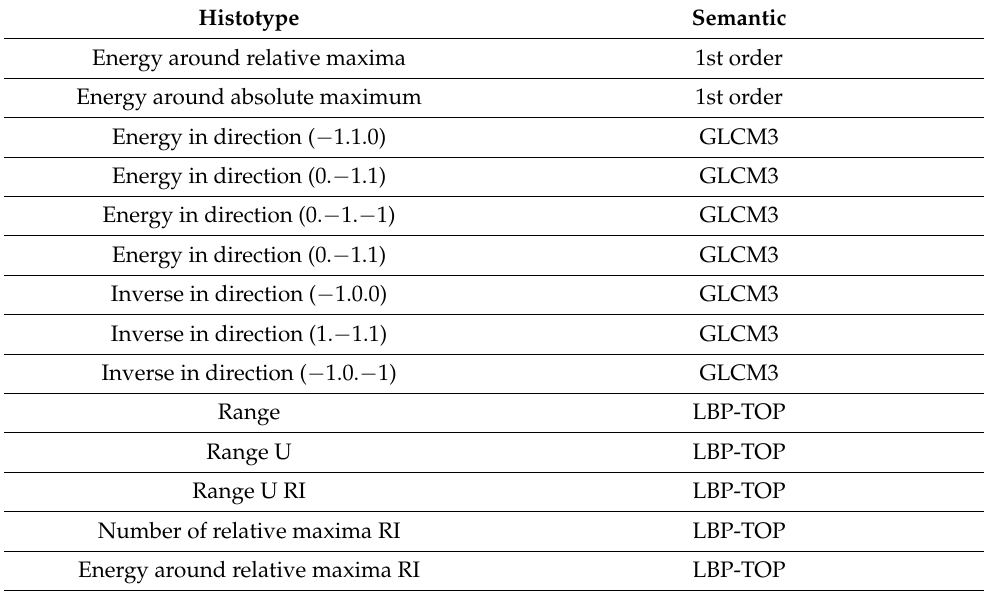
Table 2. The final feature